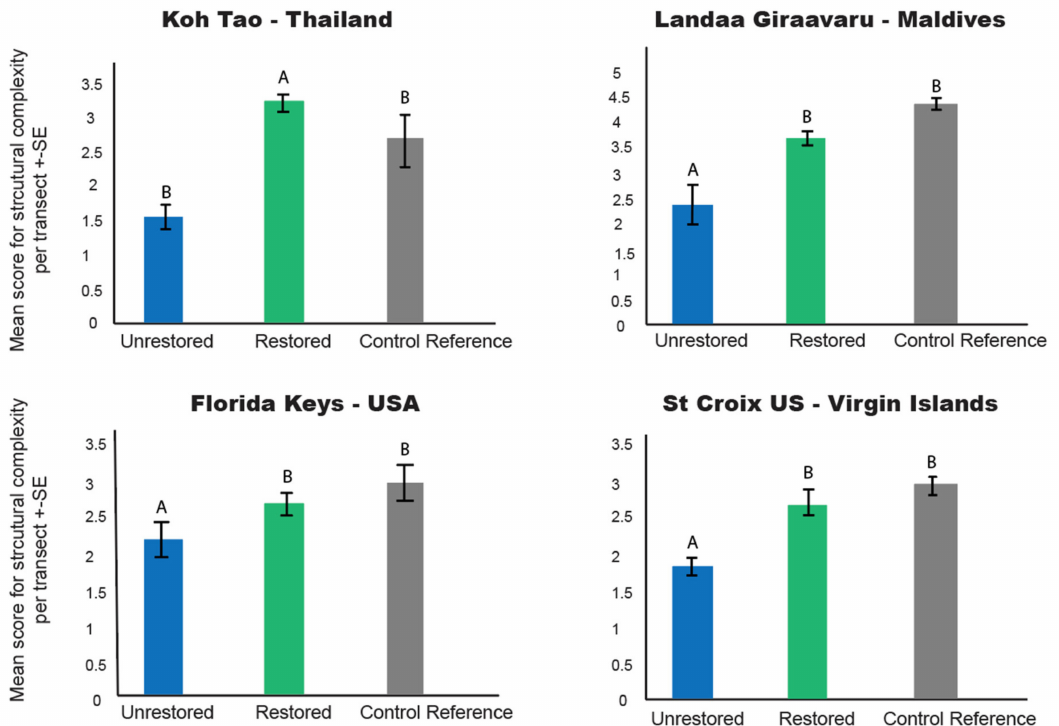
Figure 4. Mean structural complexity scores ( ± SE) compared among treatments (unrestored, restored, control reference sites) at each of the four locations. Letters above each histogram indicate whether mean values di ff er significantly (di ff erent letters) or are statistically indistinguishable (same letters). n = 9 transects per treatment in Koh Tao, Landaa Giraavaru, and the Florida Keys; in St Croix, n = 8 transects for unrestored and restored treatments, n = 6 transects for the control reference